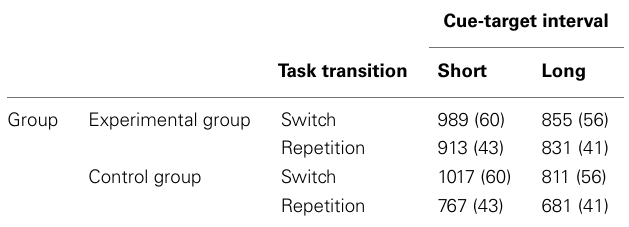
Table 1 | Mean RT in ms (and SE) of the first eight blocks (acquisition phase) as a function of task transition (repetition vs. switch), CTI (short vs. long), and group (Experimental group vs. Control